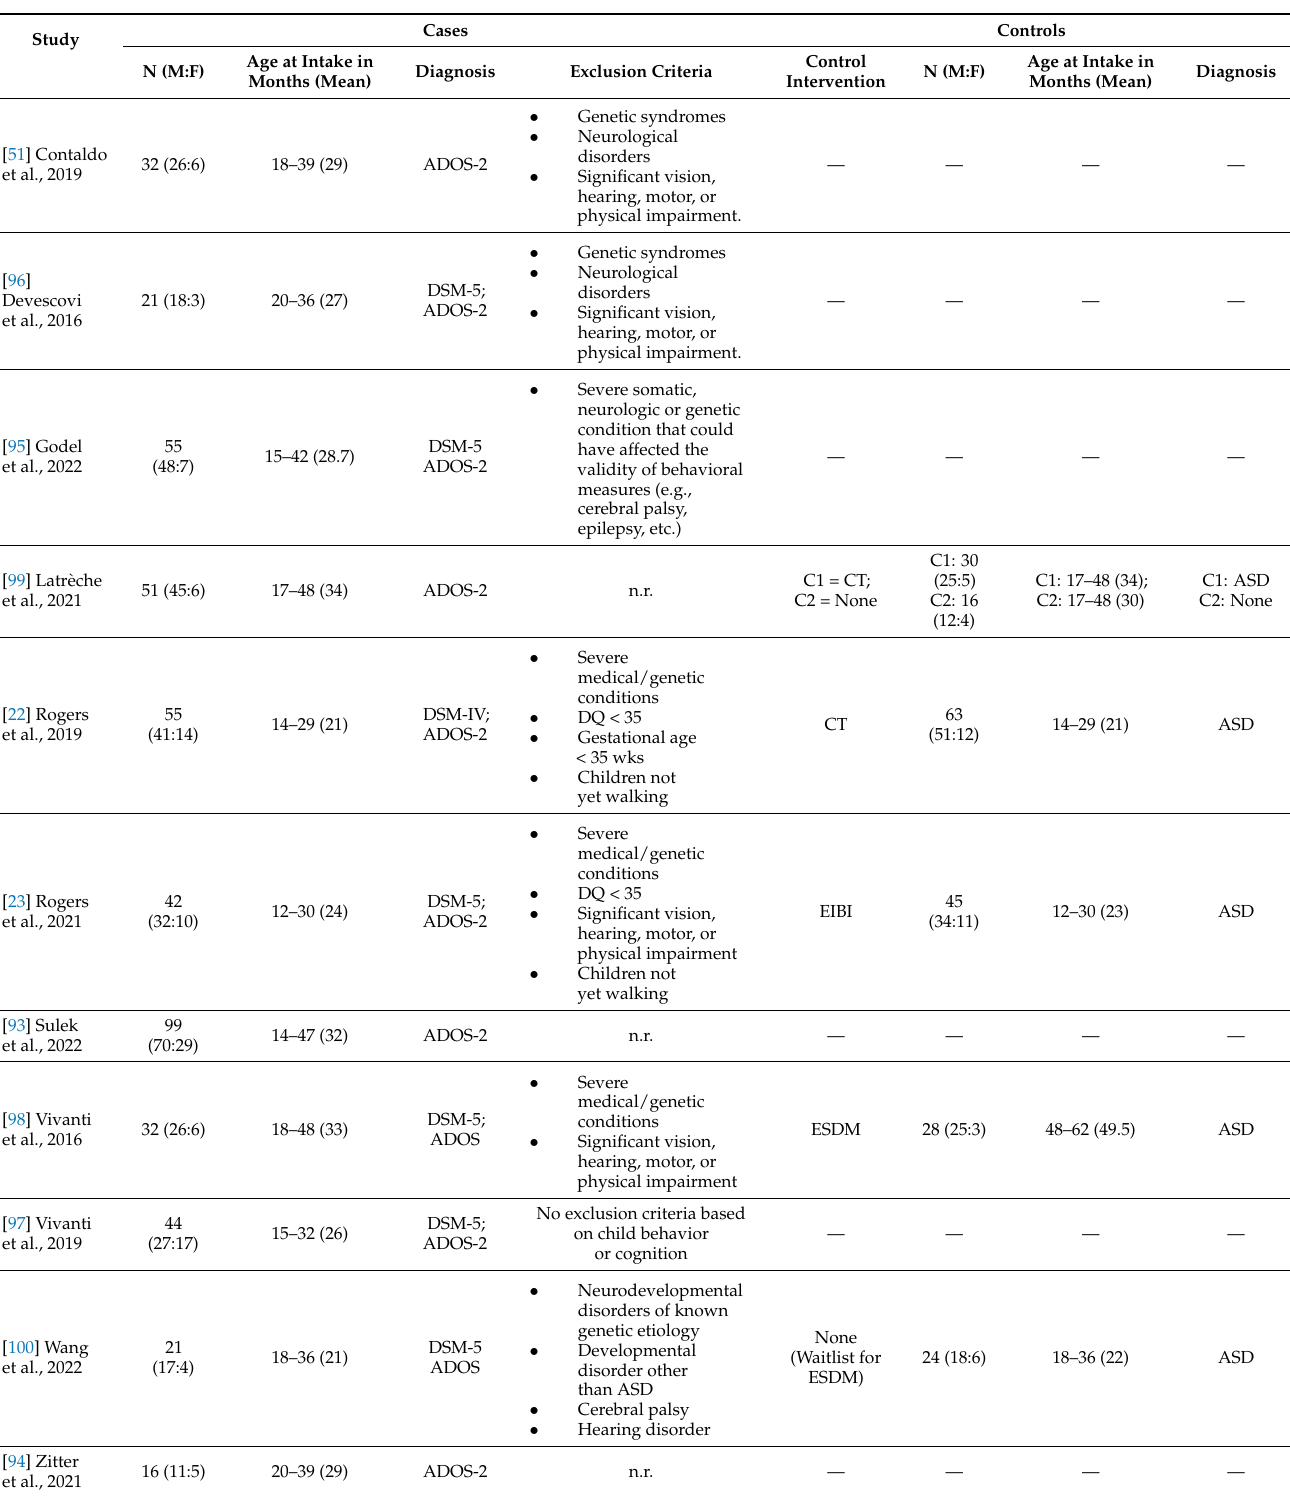
Table 4. Summary of ESDM studies: sample